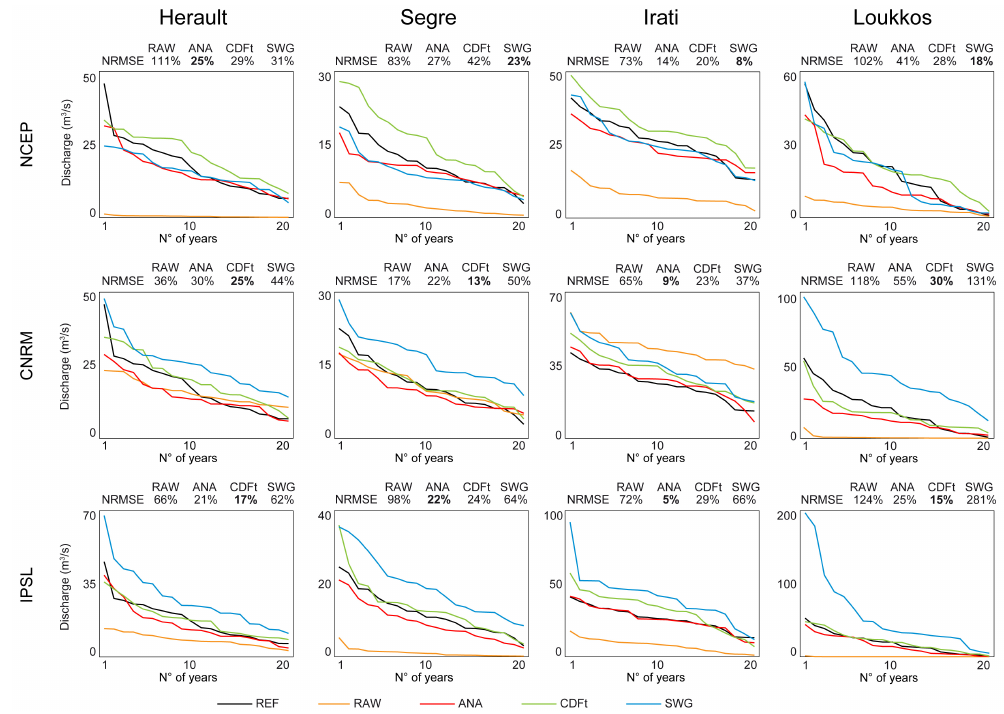
Figure 7. Comparison of the sorted annual discharge simulated using REF data, RAW (NCEP or GCM) data, and the three downscaling methods (applied to NCEP, CNRM and IPSL) for each basin. The NRMSE values above each panel represent a root mean square error applied to the sorted time series of annual discharge normalized by dividing RMSE by the mean annual discharge of the reference time series. The best values are in